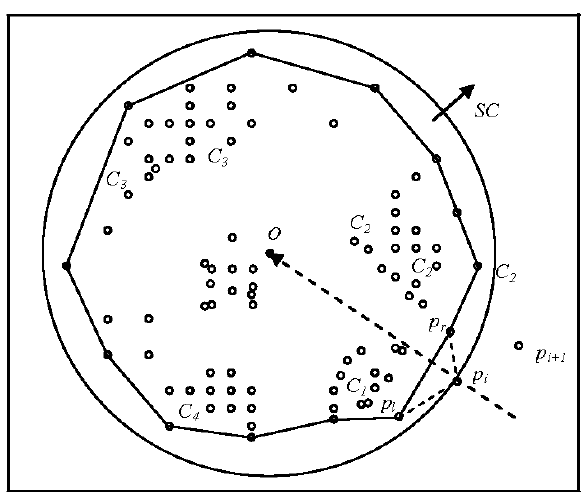
Figure 3. Sweeping the data set to obtain clusters.